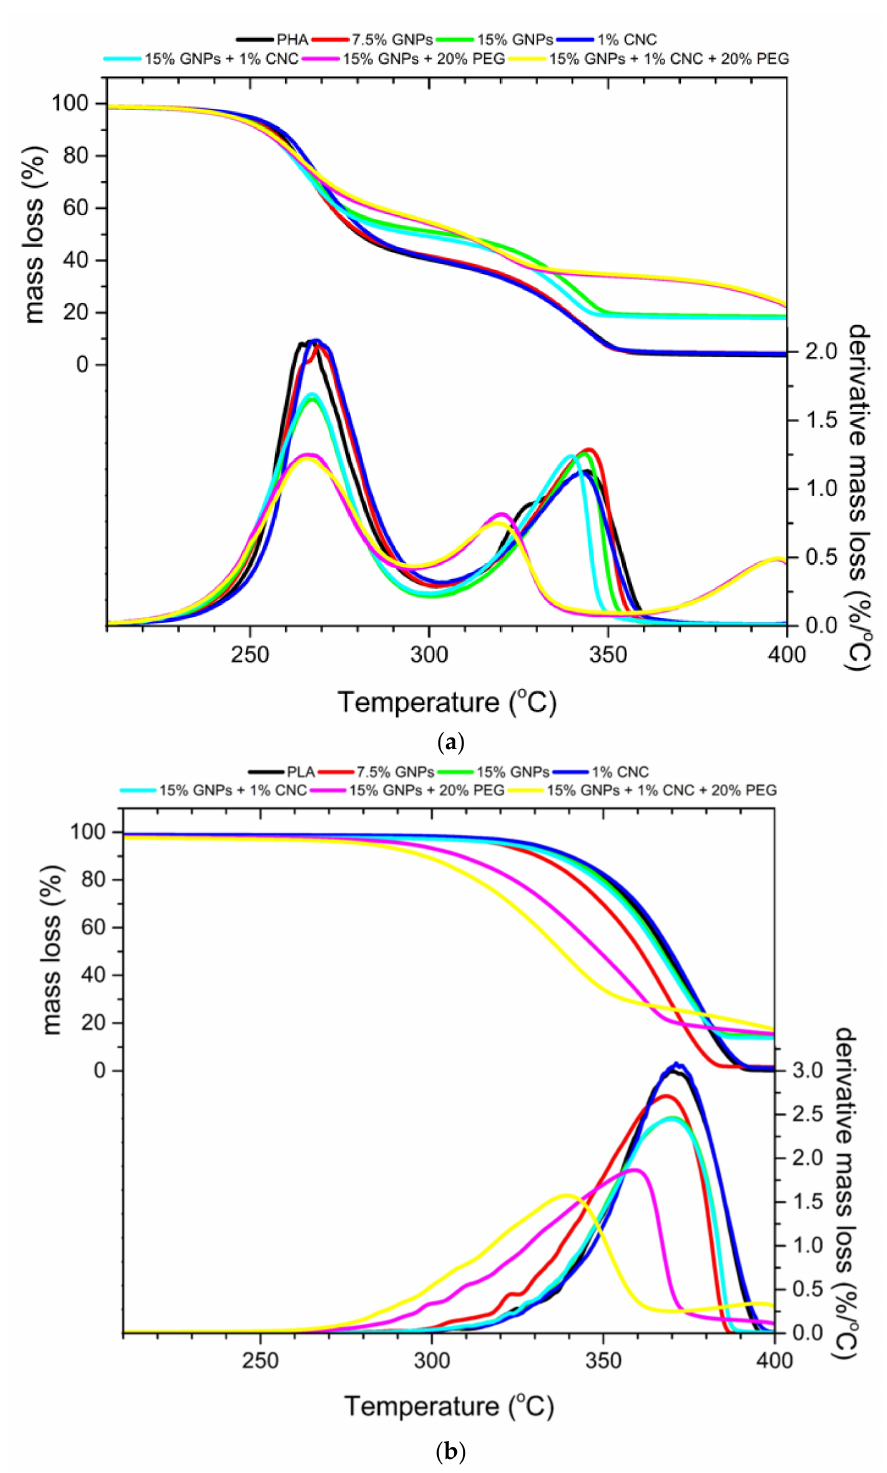
Figure 5. ( a ) Thermogravimetric curves of PHA films with different additions by mass: graphene nanoparticles (GNPs), cellulose nanocrystals (CNC) and polyethylene glycol (PEG). ( b ) Thermo- gravimetric curves of PLA films with different additions by mass: graphene nanoparticles (GNPs), cellulose nanocrystals (CNC) and polyethylene glycol